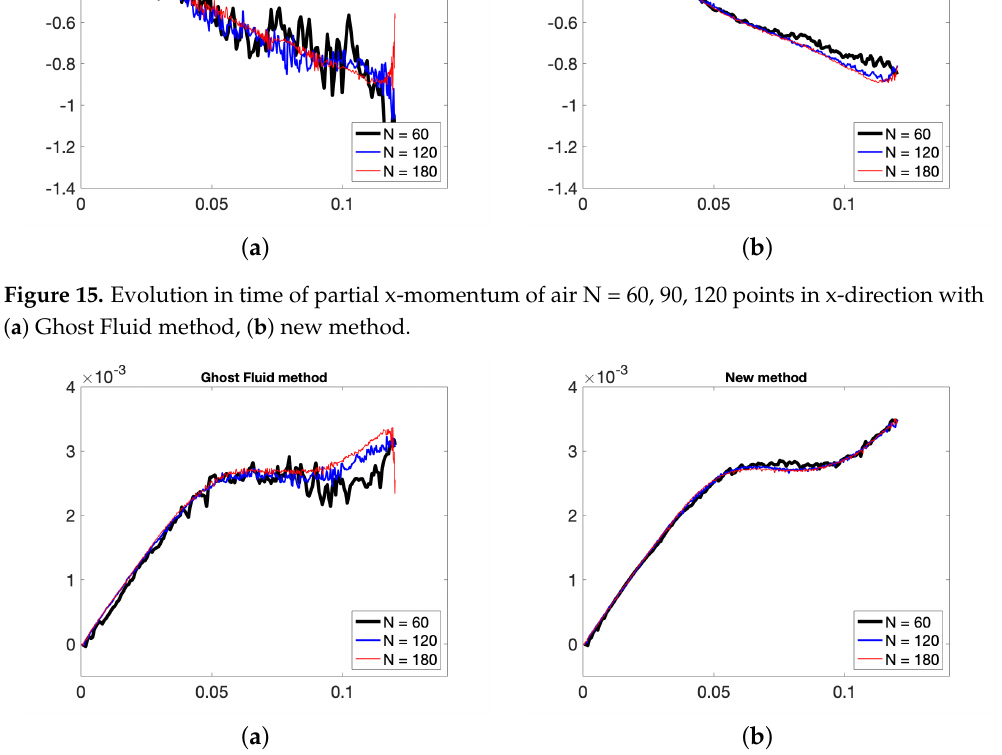
Figure 16. Evolution in time of partial y-momentum of air N = 60, 90, 120 points in x-direction with ( a ) Ghost Fluid method, ( b ) new